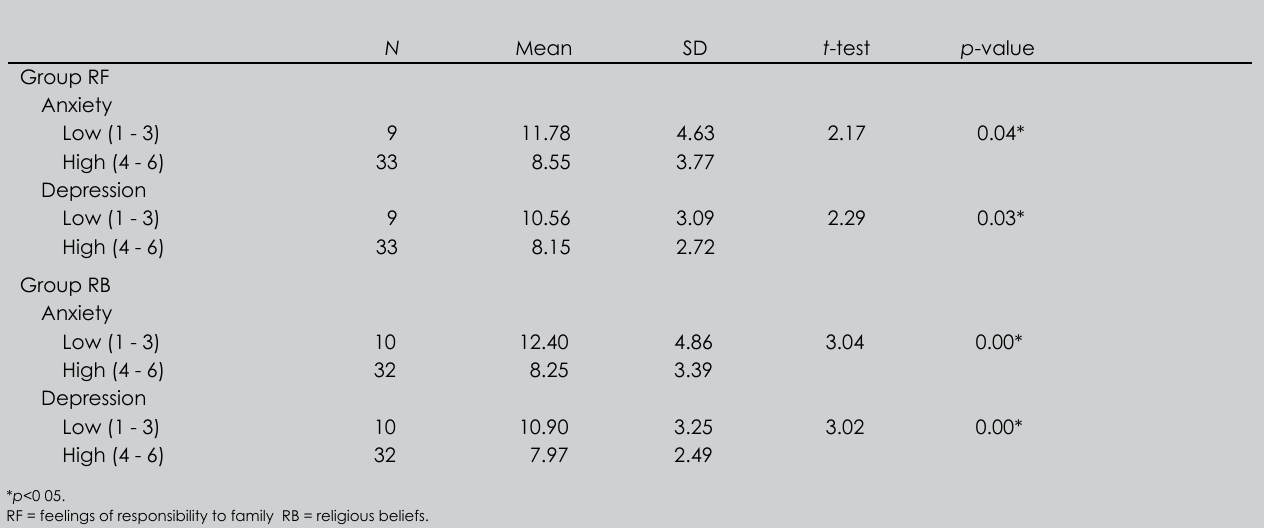
Table VI. Comparisons of low and high RF and RB with HADS